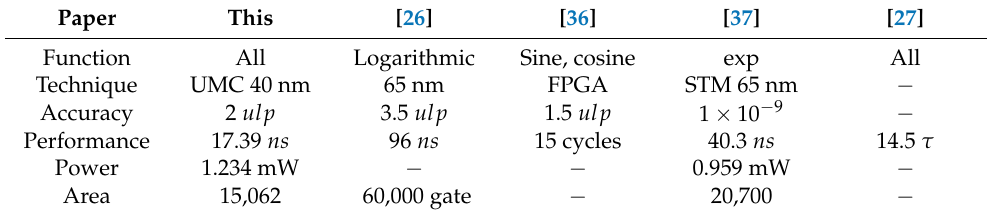
Table 8. Comparison of results with state-of-the-art hardware